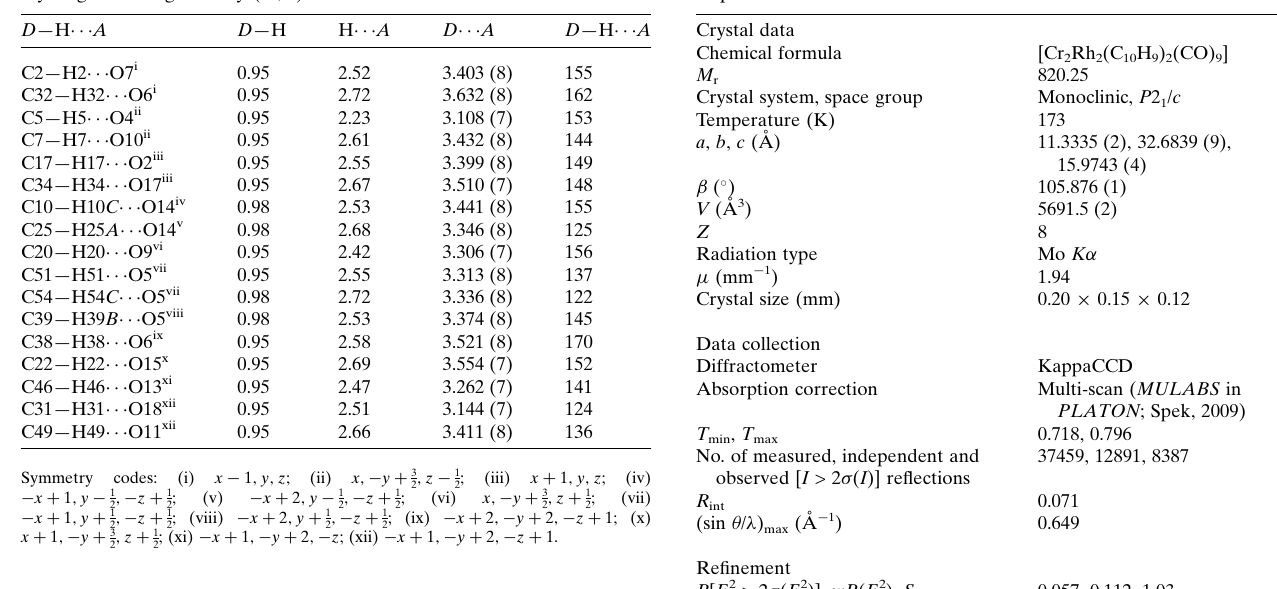
Table 1 Hydrogen-bond geometry (A˚ , (cid:5) ).